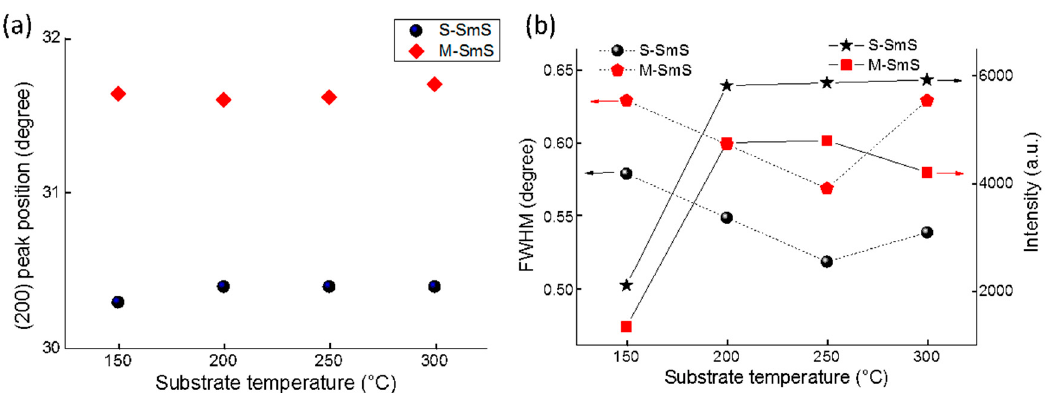
Figure 3. ( a ) Position of the (200) di ff raction peak for the as-deposited and switched SmS thin films, as a function of substrate temperature. The thin films were deposited at a rate of 0.8 nm / s and at an H 2 S partial pressure of 10 − 5 mbar. ( b ) FWHM (in degree) and the di ff raction peak intensity (in a.u.) for the same lattice plane. The background of each XRD measurement was subtracted before calculating the FWHM and peak intensity.